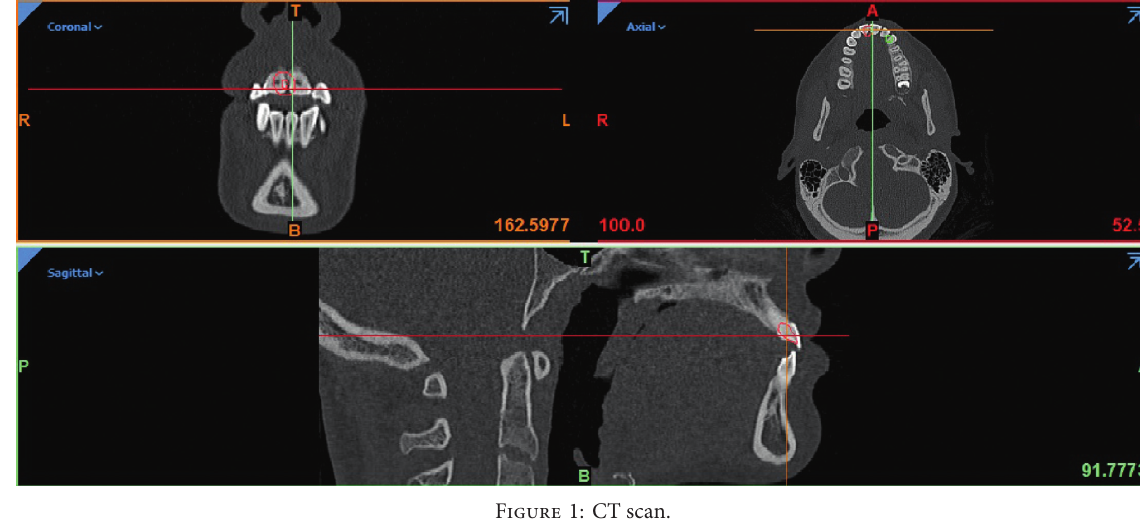
Figure 1: CT scan.